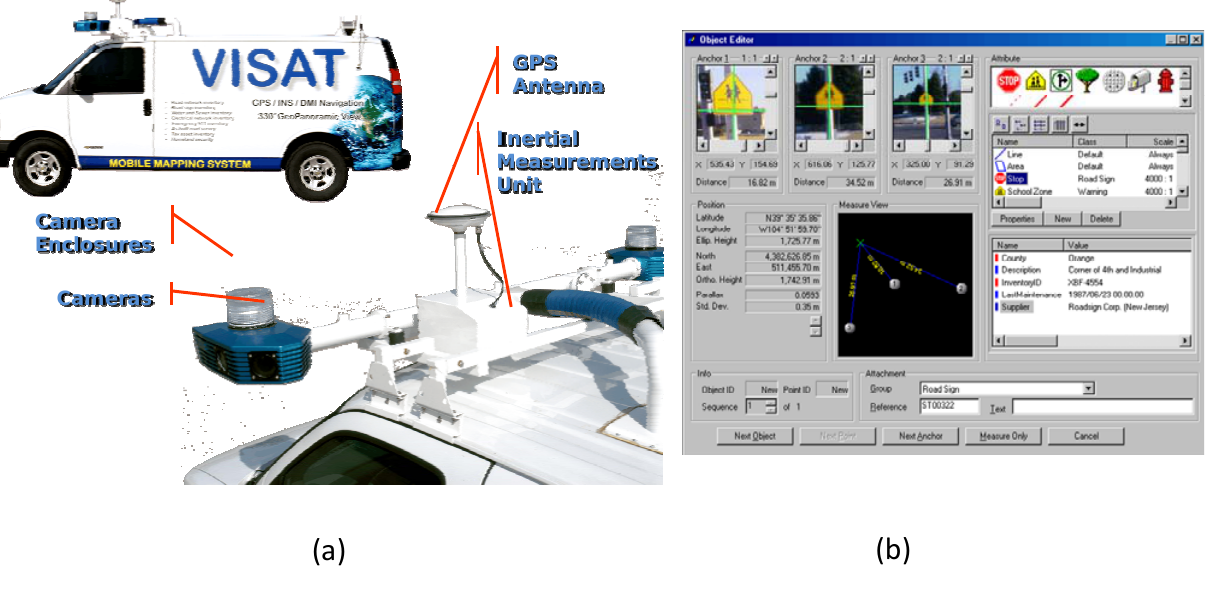
Figure 1. (a) An example of land based MMS (b) An example of direct geo-referencing an object of interest (Adopted from